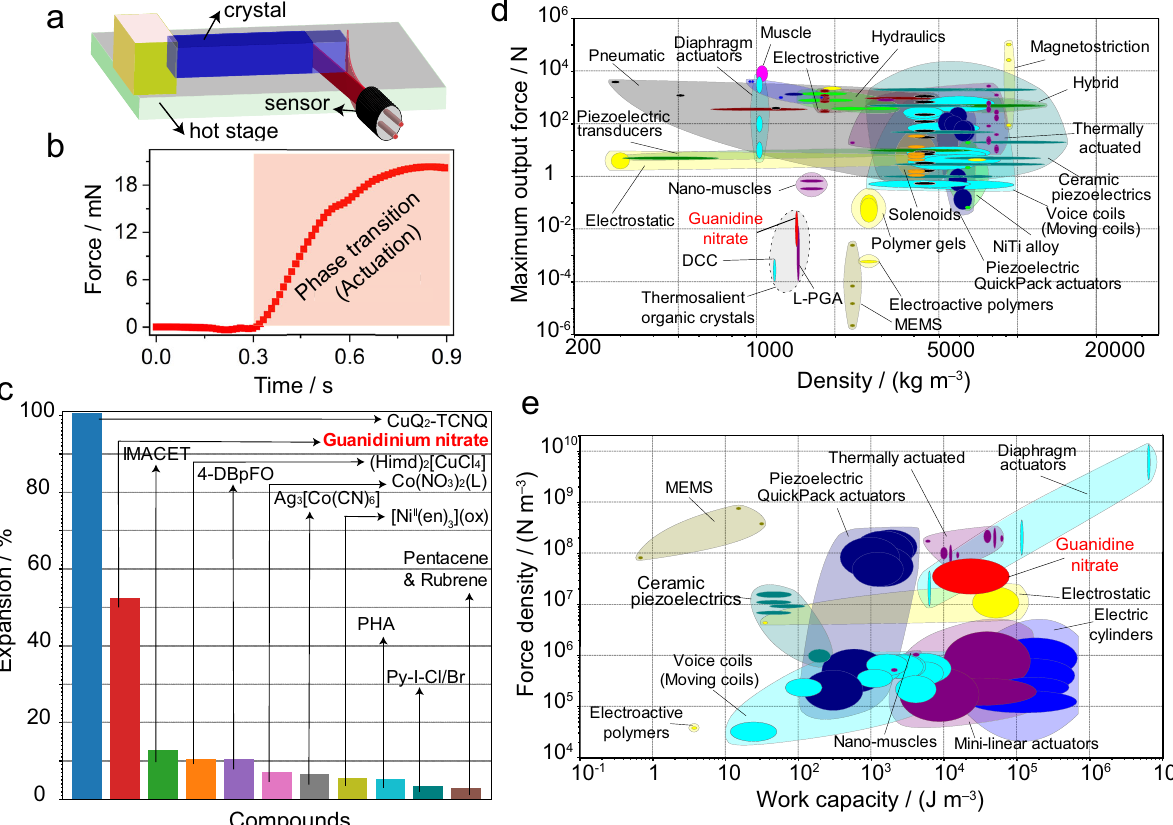
Fig. 3 Evaluating the actuating performance of guanidinium nitrate crystals. a A setup used to measure the force generated by GN single crystals upon thermal expansion. b Force measured during phase transition of form I to form II during heating as a function of time (in seconds). c Comparison of thermal expansion of GN to other organic crystals. d Maximum output force versus density of GN and two other thermosalient materials (L-pyroglutamic acid and a DABCO-carbazole cocrystal) 5,21,32 co-plotted together with other common actuator classes. e Work capacity versus density of GN co-plotted with the same attributes for other main actuator classes. The opaque bubbles represent the range of performance indices values of a particular material, while the other translucent envelopes group together materials belonging to the same actuator